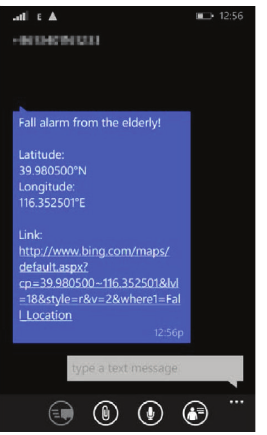
Figure 12: Fall alarm SMS which contains fall location URL.